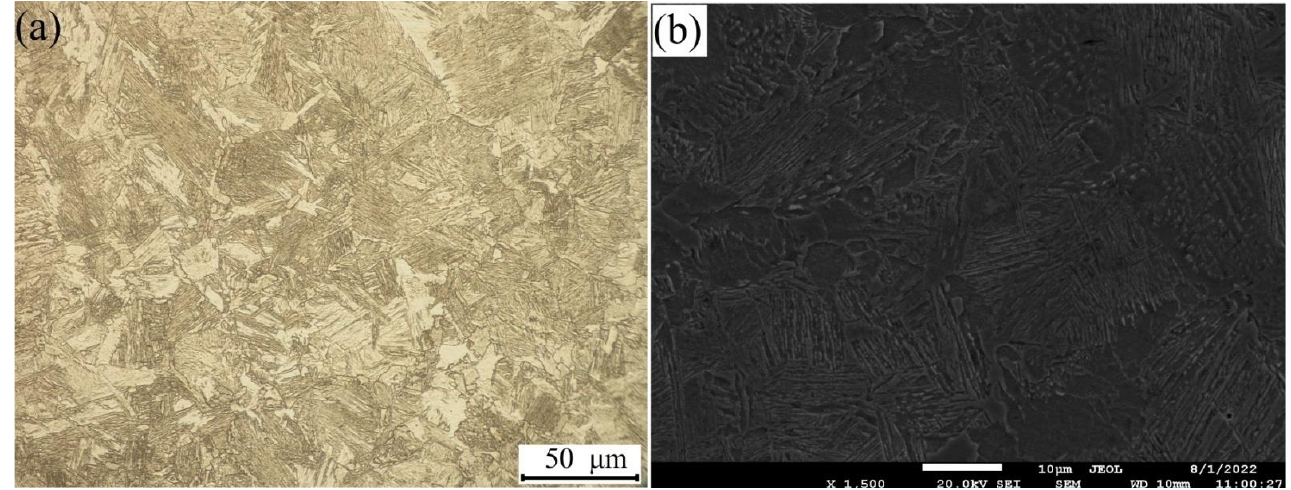
Figure 4. The microstructure of the CGHAZ: ( a ) OM; ( b ) SEM.